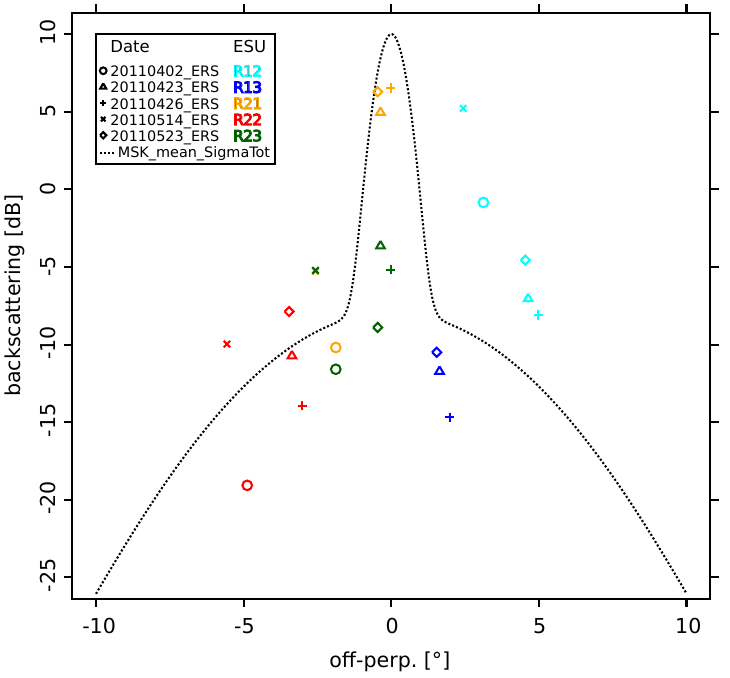
Figure 8. Backscattering [dB] versus row direction (0 ◦ = rows perpendicular to the incidence wave) for the roughness samples plots and results of the Modified Shin and Kong model ([8]) averaged for sugar beet parametrization and five ERS-2 scenes (dashed line) acquired nearly simultaneous to the roughness